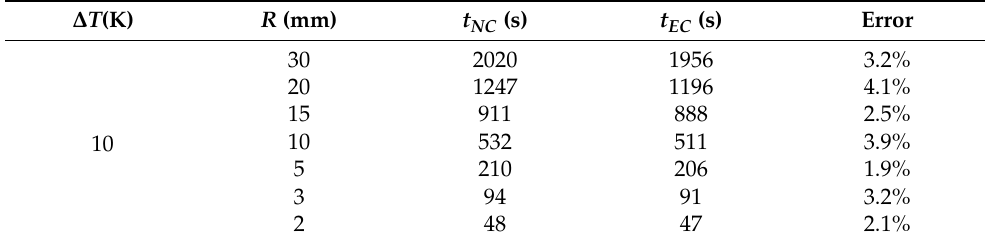
Table 3. Total melting times for the NC and EC models for different sphere sizes and ∆ T = 10 K. ∆ T (K) R (mm) t NC